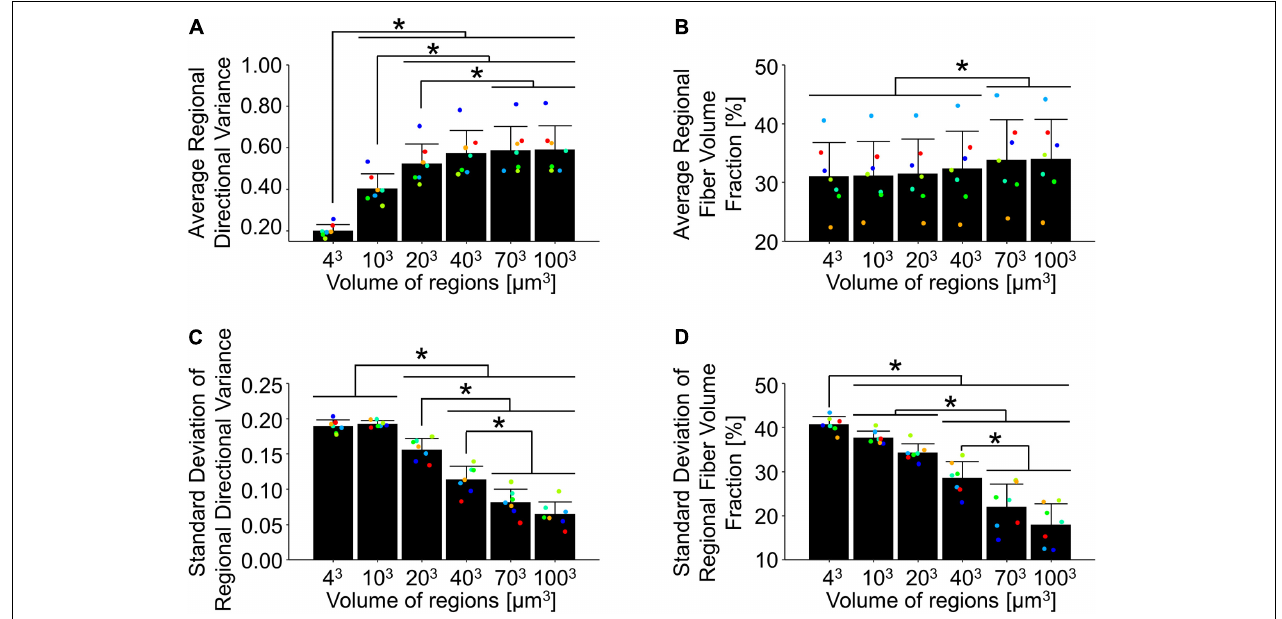
FIGURE 7 | In the undeformed configuration, regional averages of directional variance (A) and fiber volume fraction (B) increased as a function of the length scale over which they were measured. Alternatively, the average regional standard deviations of directional variance (C) and fiber volume fraction (D) decreased at larger length-scales, indicating the importance of length-scale when implementing measurements into computational models. Points are colored to indicate paired comparisons among groups. *represents p <